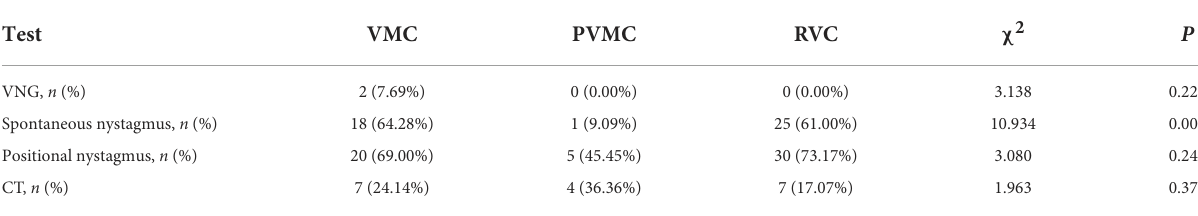
TABLE 2 Comparison of abnormal VNG